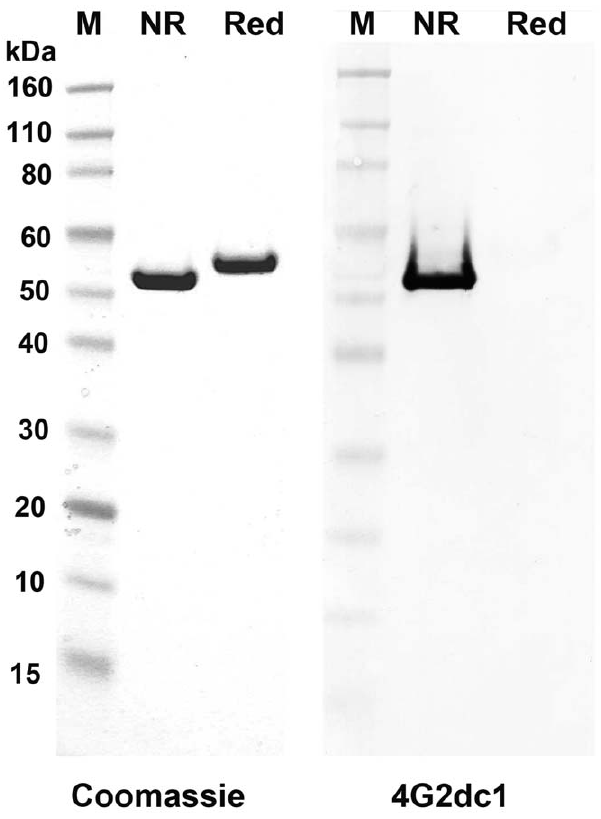
Figure 1. Recombinant 3D7 AMA1 vaccine was pure and folded correctly. Left panel shows a coomassie blue stained SDS-PAGE analysis of the 3D7 AMA1 vaccine under non-reducing (NR) and reducing conditions (Red). Right panel shows positive reactivity of only the non-reduced 3D7 AMA1 protein with a conformational monoclonal antibody 4G2dc1.